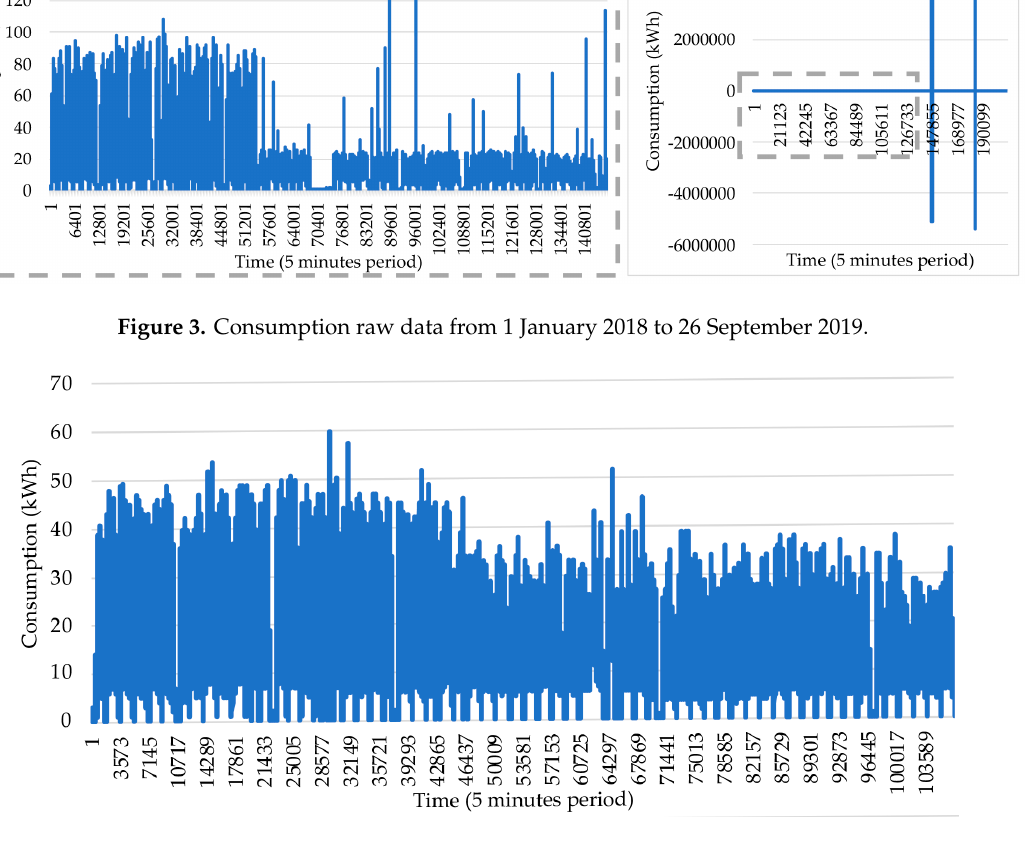
Figure 4. Consumption cleaned data from 1 January 2018 to 13 April